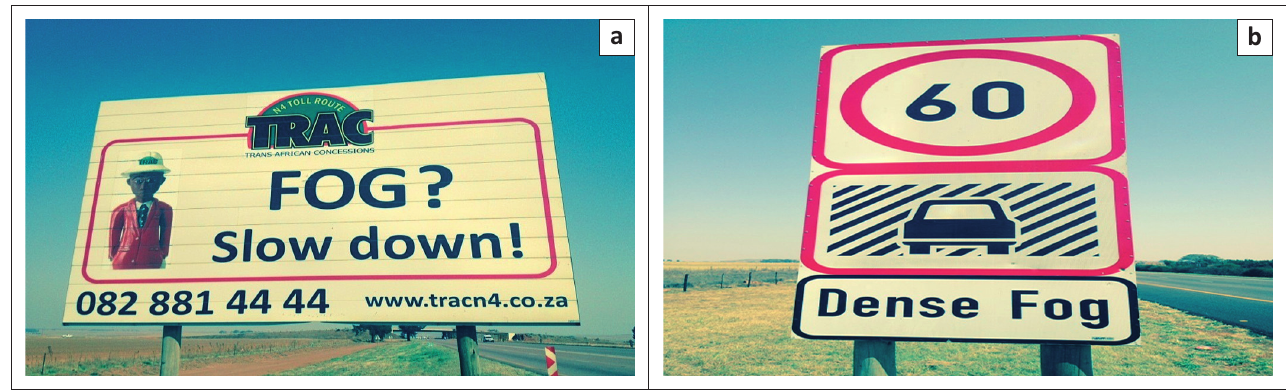
FIGURE 3: Fog sign (a) along the N4 road and a heavy fog (b) sing along the N4 road in Mpumalanga Province.